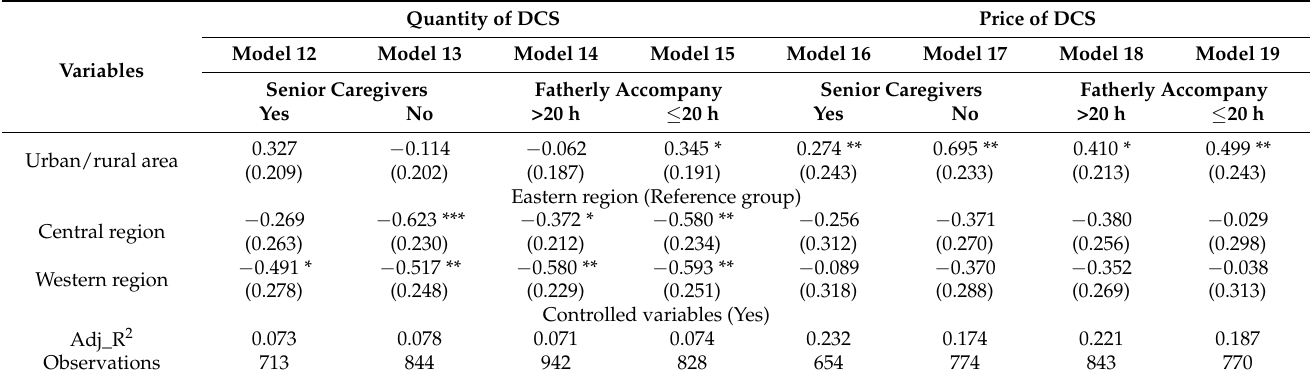
Table 4. The moderating effect of the current status of LGFC.